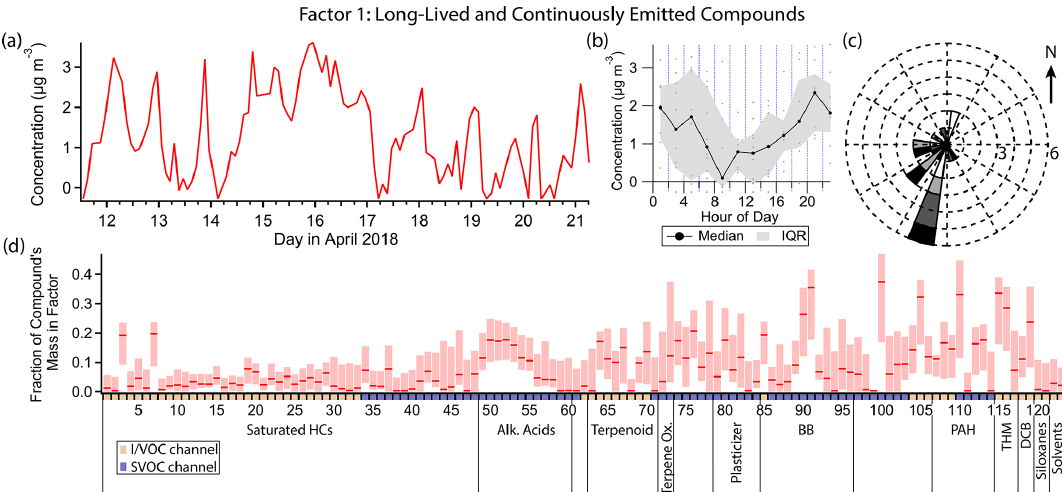
Figure 4. (a) Factor 1 timeline. Date labels are at midnight. (b) Diurnal profile for Factor 1. IQR = interquartile range. (c) Rose plot showing the correlation of emissions and wind direction, using only data points where the concentration was elevated, defined as > 1 standard deviation above the mean factor concentration. Frequency of observations are represented by the length of each wedge, where each ring corresponds to one observation. Shading corresponds to quartiles of factor concentration (darker = greater concentration). (d) Factor 1 composition profile. Compounds are ordered as in Table 1 using the indices assigned. Unlabeled groups are labeled “other” in Table 1. The shaded areas behind each profile represent 5th and 95th percentile contributions based on bootstrapping analysis, as described in Sect.